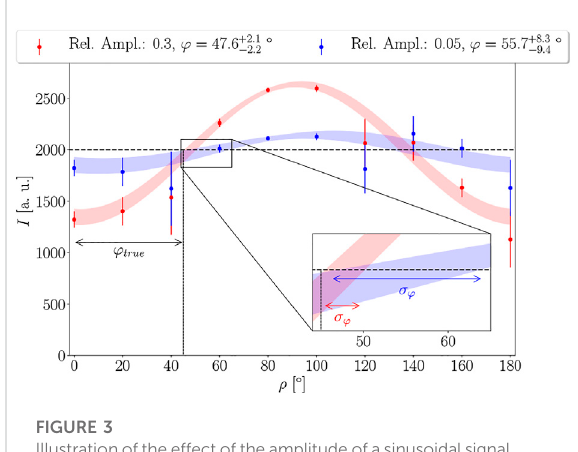
FIGURE 3 Illustrationoftheeffectoftheamplitude ofasinusoidalsignal on the uncertainty of the extracted phase. Both datasets were generated with the same offset of I T = 2000, phase φ = 45 ° , and noise levels. The phase can be inferred with higher accuracy and a lower degree of uncertainty for a higher amplitude. Shaded areas represent 95% prediction intervals for the sinusoidal model.